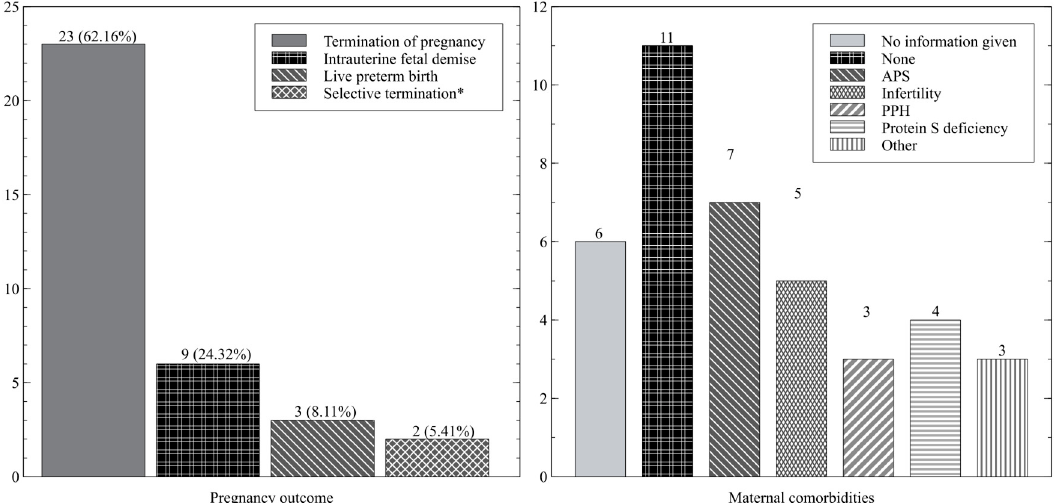
Figure 2. Preeclampsia onset week and the week of the pregnancy end by the number of cases reported.